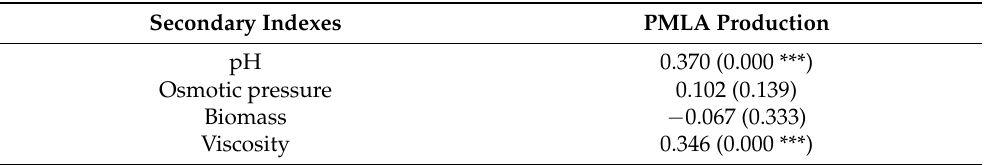
Table 3. The correlation matrix of PMLA production and secondary indexes, pH, osmotic pressure, biomass, and viscosity.